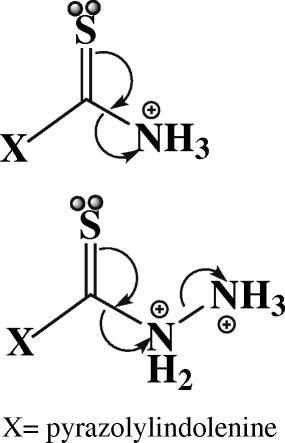
Structure and electron transfer mechanism of protonated InPzTAm and InPzTH, (X= pyrazolylindolenine).